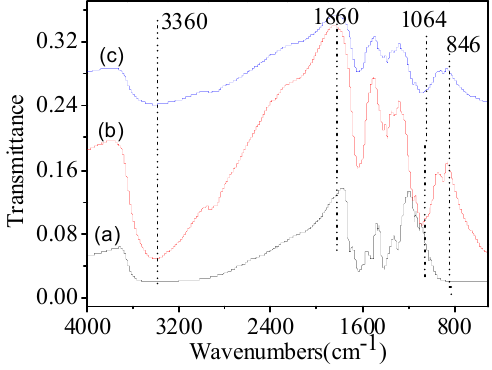
Figure 2. FTIR spectra of ( a ) MIL-125, ( b ) MIL-125-CS and ( c ) MIL-125-CS-Pb.